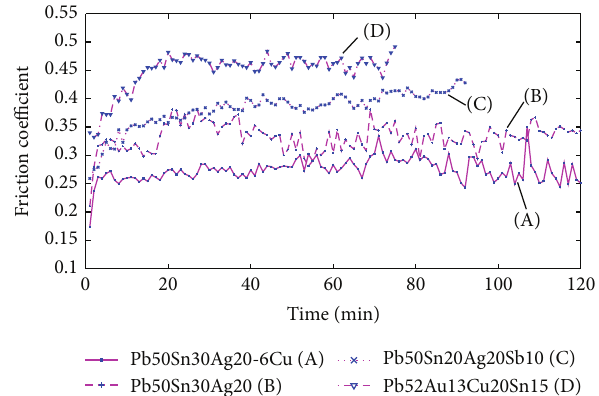
Figure 6: Friction coefficients of ceramic composite with gradient layer infiltrated with different soft alloys on A 2 O 3 disk.